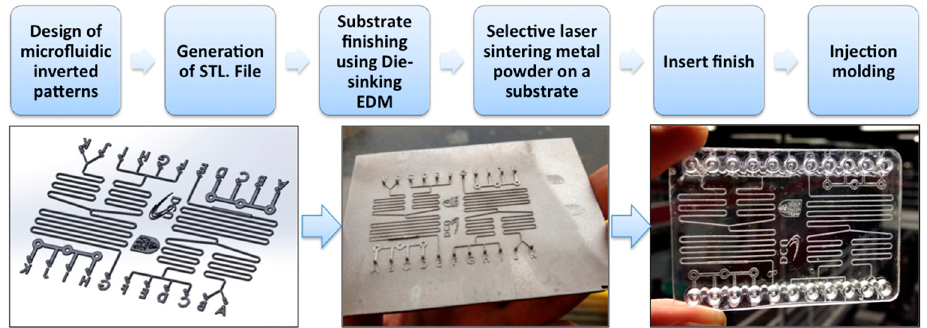
Figure 4. Manufacturing process chain for prototyping plastic devices using selective laser melting (SLM).